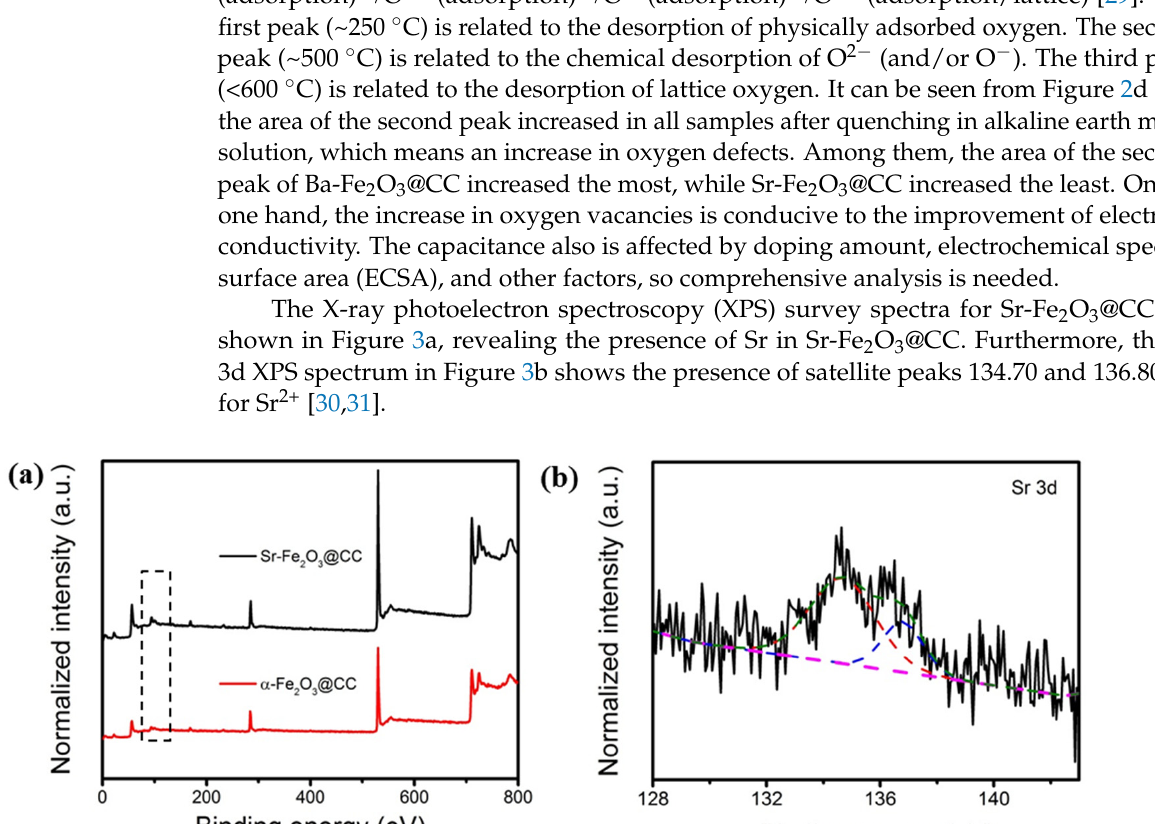
Figure 2. ( a ) XRD patterns for FeOOH. ( b ) XRD patterns, ( c ) Raman spectra, and ( d ) O 2 -TPD patterns for α -Fe 2 O 3 @CC, Sr- Fe 2 O 3 @CC, Ba-Fe 2 O 3 @CC, Mg-Fe 2 O 3 @CC, and Ca-Fe 2 O 3 @CC.